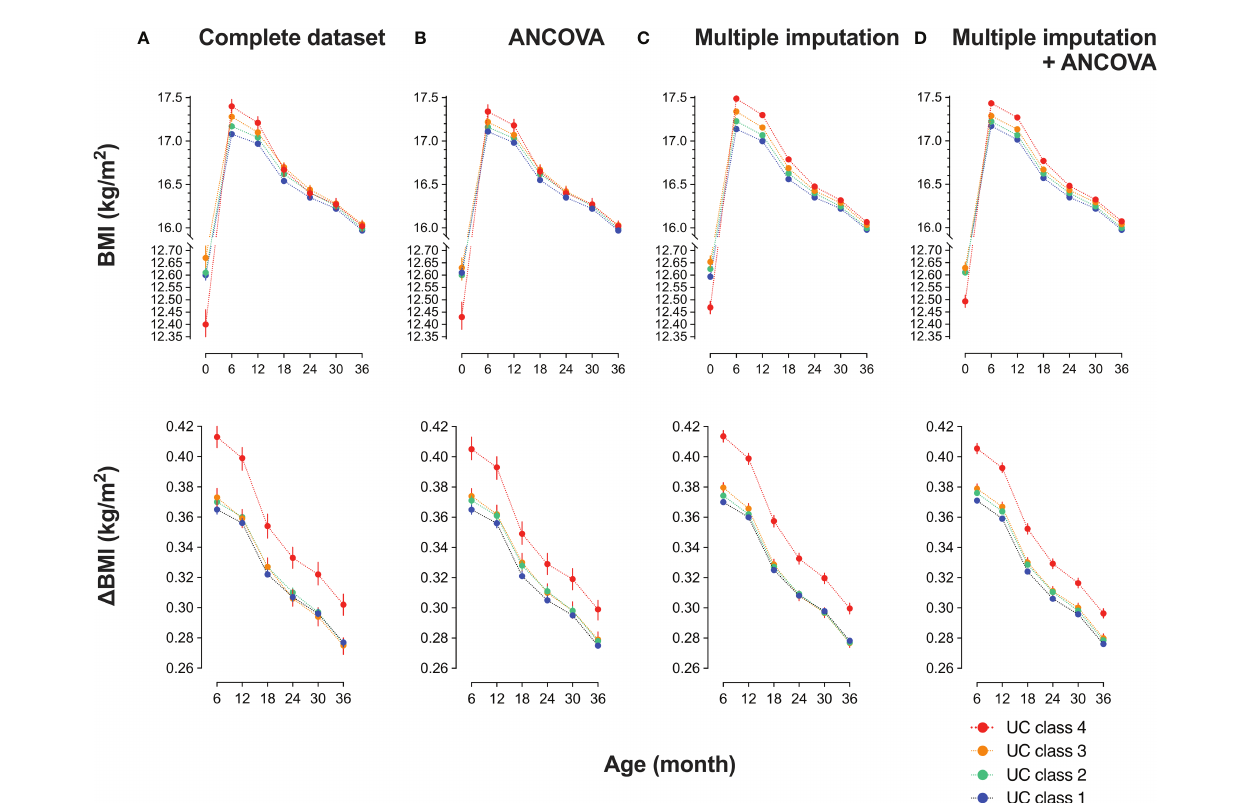
FIGURE 2 | Trends in body mass index (BMI) of participants in urinary cotinine (UC) classes before and after multiple imputations Participants were categorized into four classes according to log 10 UC levels [log 10 (ng/mL)]: class 1: < − 1, class 2: < − 1 to 0, class 3: <0 – 1, class 4: ≥ 1. The trend in BMI and the differences from baseline ( D BMI) are shown according to UC class before and after multiple imputations. Values are shown in (A) a complete set (n = 35829); (B) complete set plus repeated measured analysis of covariance (ANCOVA) corrected by covariates: mother ’ s age at delivery (years), pre-pregnancy BMI (kg/m 2 ), regular alcohol drinking (yes or no), hypertension (yes or no), diabetes mellitus (yes or no), infant sex, pregnancy period, maternal education of ≥ 16 years (yes or no), paternal education of ≥ 16 years (yes or no), household income (1, <4 million; 2, ≥ 4 million and <8 million; 3, ≥ 8 million and <12 million; 4, ≥ 12 million in Japanese Yen); (C) dataset (n = 89617) imputed the missing confounders on BMI at six, nine, 12, 18, 24, and 36 months, maternal age, BMI before pregnancy, body weight gain during pregnancy, alcohol drinking during pregnancy, maternal and paternal education of ≤ 16 years, and class of annual household income; and (D) dataset imputed as in (C) plus ANCOVA done as in (B)